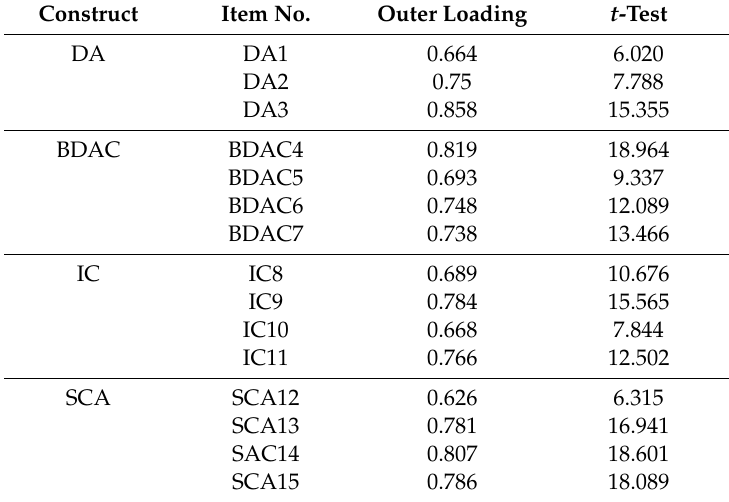
Table 5. Estimation of the outer model.